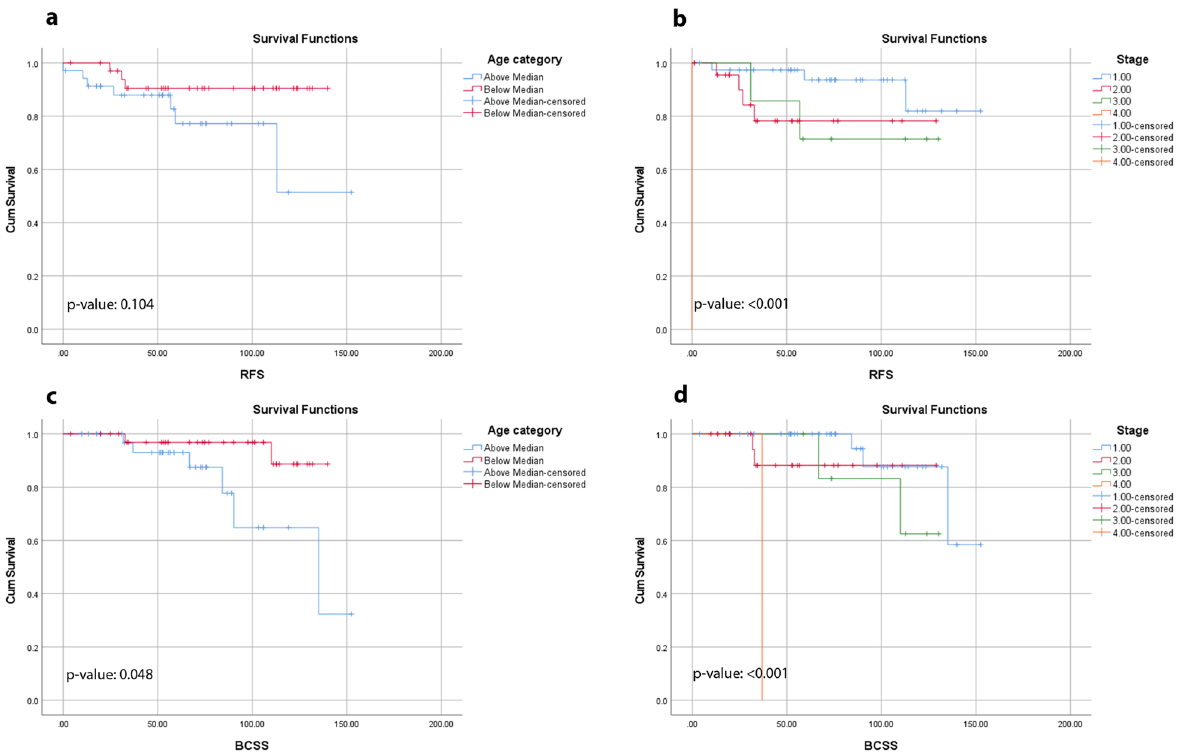
Fig. 1 Survival based on age and AJCC stage. Kaplan – Meier survival curves for recurrence-free (RFS) and breast cancer-speci fi c survival (BCSS) for age and AJCC stage ( a RFS for age, log-rank test p -value 0.104; b RFS for stage, log-rank test p -value < 0.001; c BCSS for age, log-rank